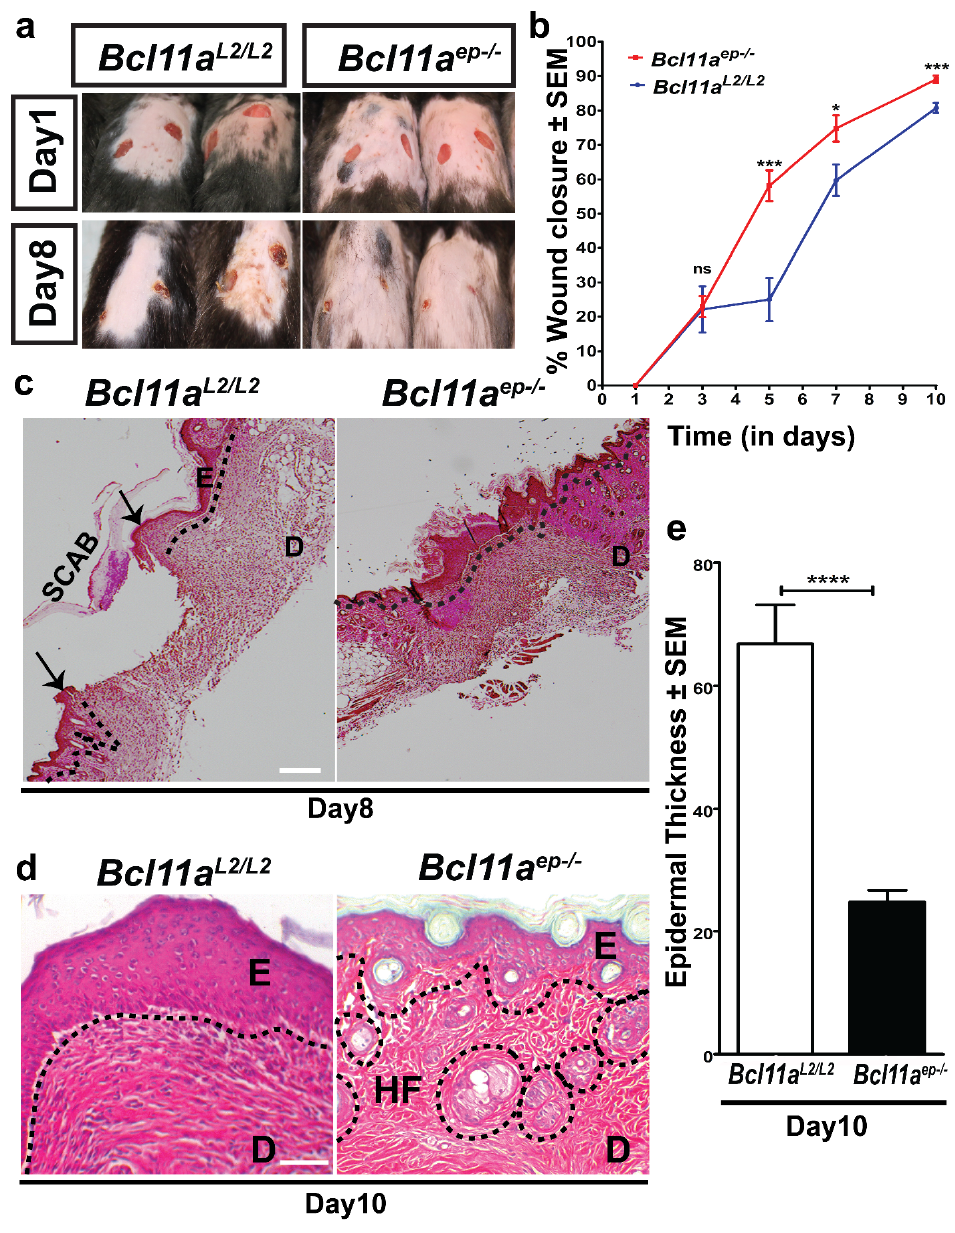
Figure 3. Accelerated wound healing in Bcl11a ep − / − mice. ( a ) Macroscopic images of the comparative healing dynamics of 5 mm full thickness excisional wounds in Bcl11a L2/L2 versus Bcl11a ep − / − mice on Day 1 and Day 8 post wounding. ( b ) Graphical representation of the rate of wound closure at various timepoints post wounding in Bcl11a L2/L2 and Bcl11a ep − / − mice. Statistical significance between the two groups at each interval were computed employing Student’s unpaired t -test (* p < 0.1, *** p < 0.001, ns < non-significant). ( c ) Hematoxylin and Eosin (H and E) stained images of the Day 8 post wounding samples. The black arrows indicate the two migratory epithelial tongues progressively moving towards each other to regenerate the denuded epidermis. ( d ) H and E-stained images of the Day 10 post wounding samples. The black dotted lines separate E from D and outline the HFs. Hyperproliferative epithelium; E—Epidermis; D—Dermis; HF—Hair follicle. Scale bar = 100 µ m. ( e ) Bar graph quantification of the relative thickness of newly formed epidermis in Bcl11a L2/L2 versus Bcl11a ep − / − mice. N = 8, where N represents the number of animals of each genotype ( Bcl11a L2/L2 or Bcl11a ep − / − ) involved in the study. Wherever applicable, multiple fields of views (FOVs) captured per sample per genotype at each timepoint to determine the statistical significance. **** p <